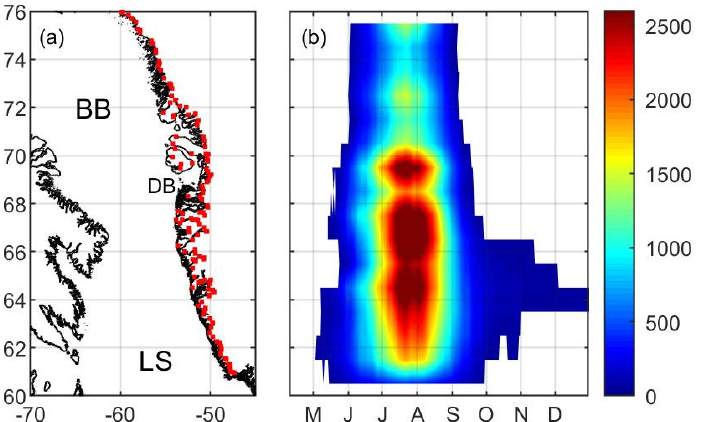
Figure 6. ( a ) Location of meltwater input from the Greenland Ice Sheet, shown by the red dots. BB: Baffin Bay; LS: Labrador Sea; DB: Disko Bay. ( b ) Climatological time series of meltwater input from the Greenland Ice Sheet (m 3 s − 1 ), integrated into 1° latitudinal bins.